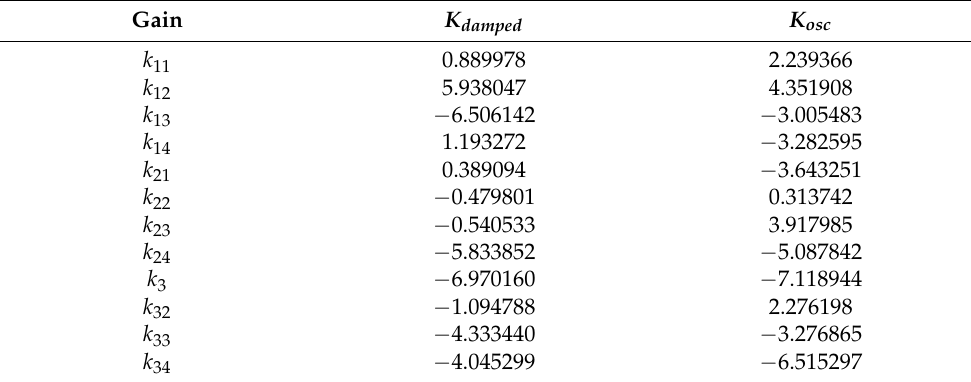
Table A2. Gains of the observer for system identification verification: K damped —damped response, K osc —underdamped response.